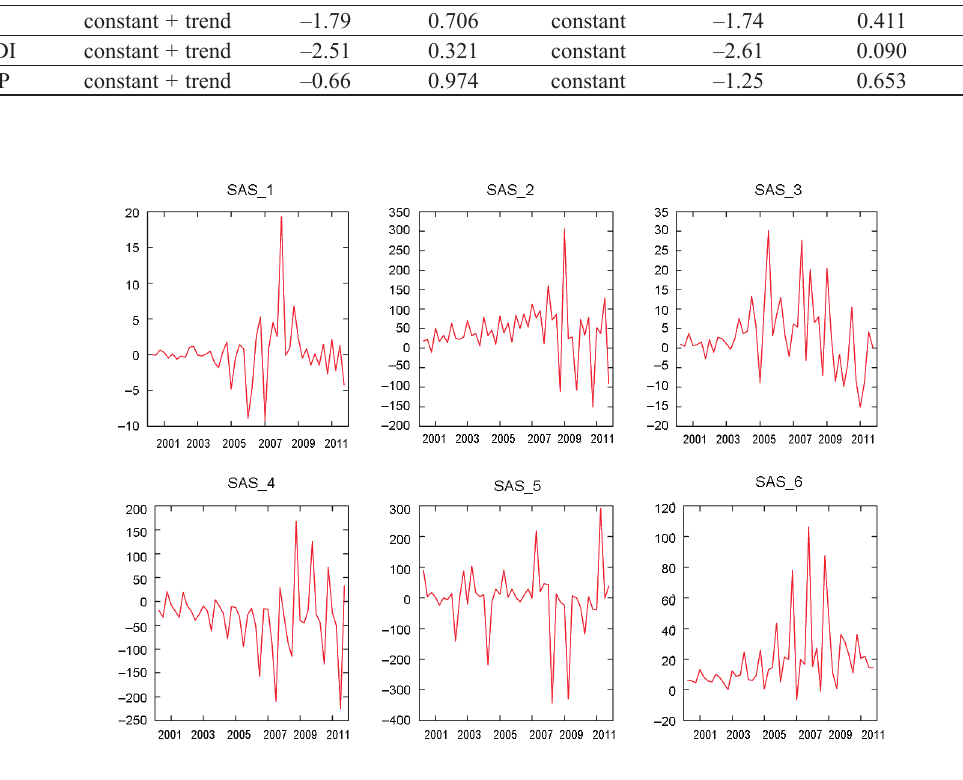
Fig. 14. The non-stationary